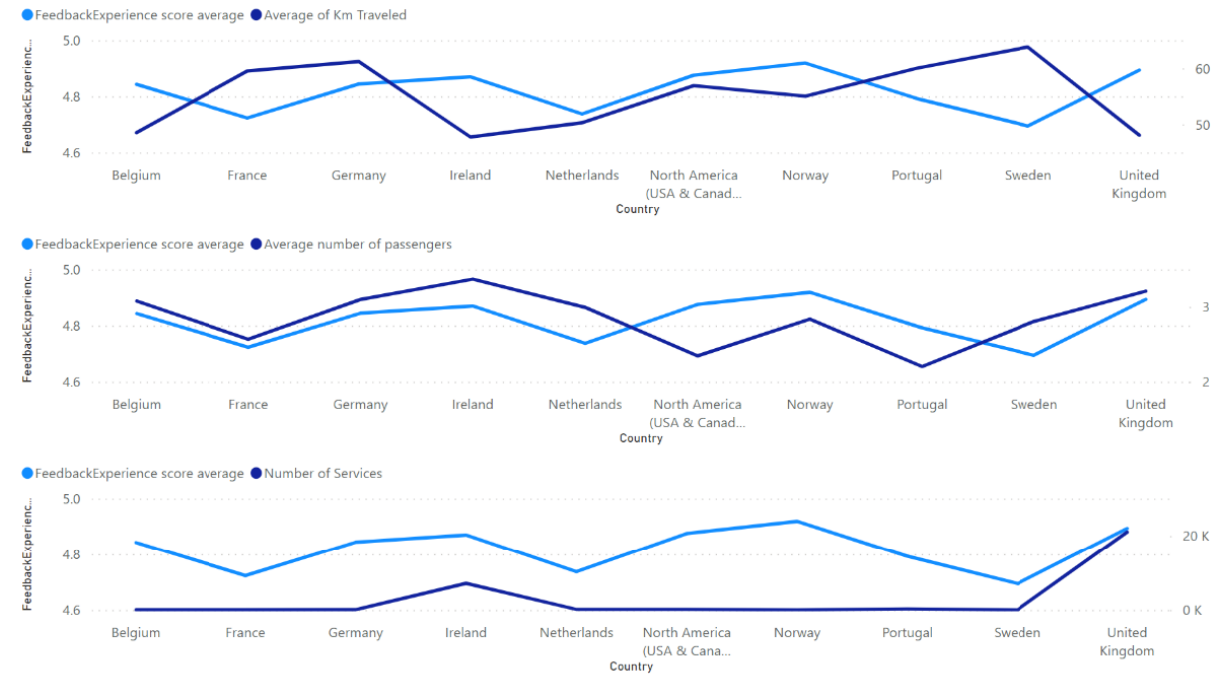
Figure 1. Comparison between the average of FeedbackExperience with the average kilometres travelled, number of services, and average number of passengers transported.